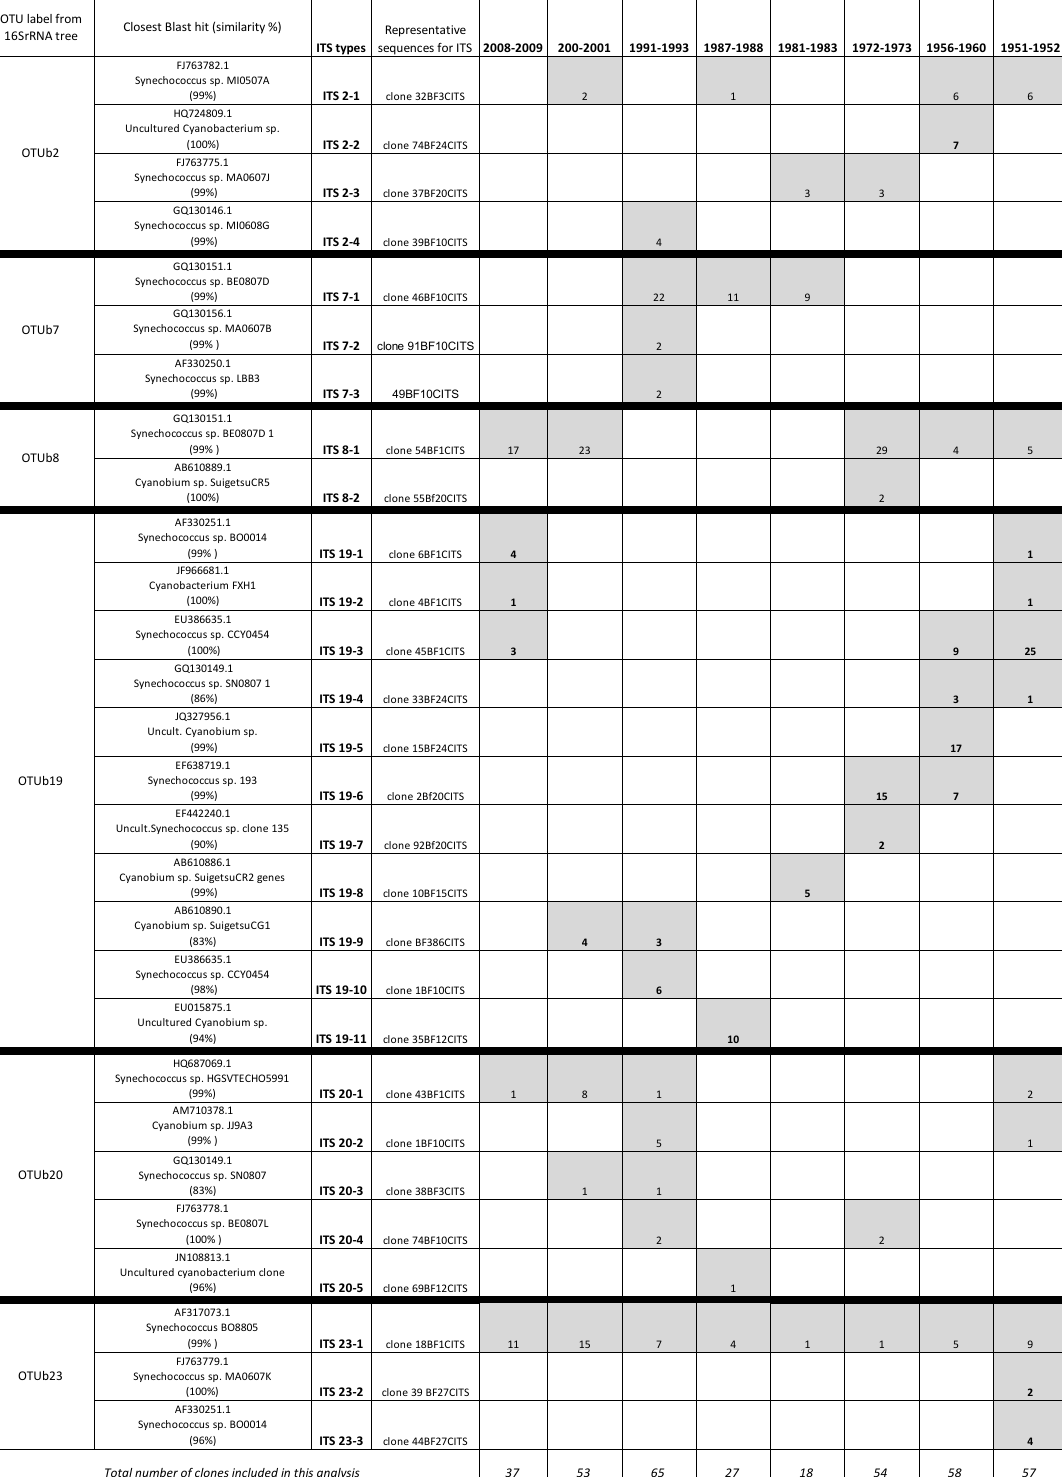
Table 4. ITS types identified for the 6 dominant OTUs (6 out of the 23 16S-based OTUs) obtained from the 8 clone libraries (2008–2009, analysis) are represented by 1 ITS Type. The number of clones associated to each ITS Type is specified in the table. The closest Blast hit (from NCBI BlastN) is specified for each ITS-Type. OTU label from 16SrRNA